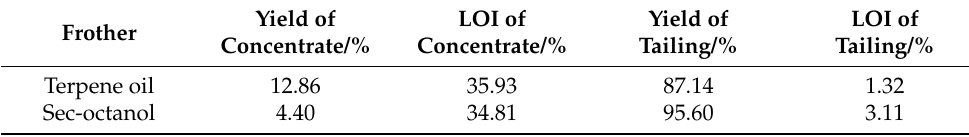
Table 2. Effect of frother types on the flotation performance of FEBFS